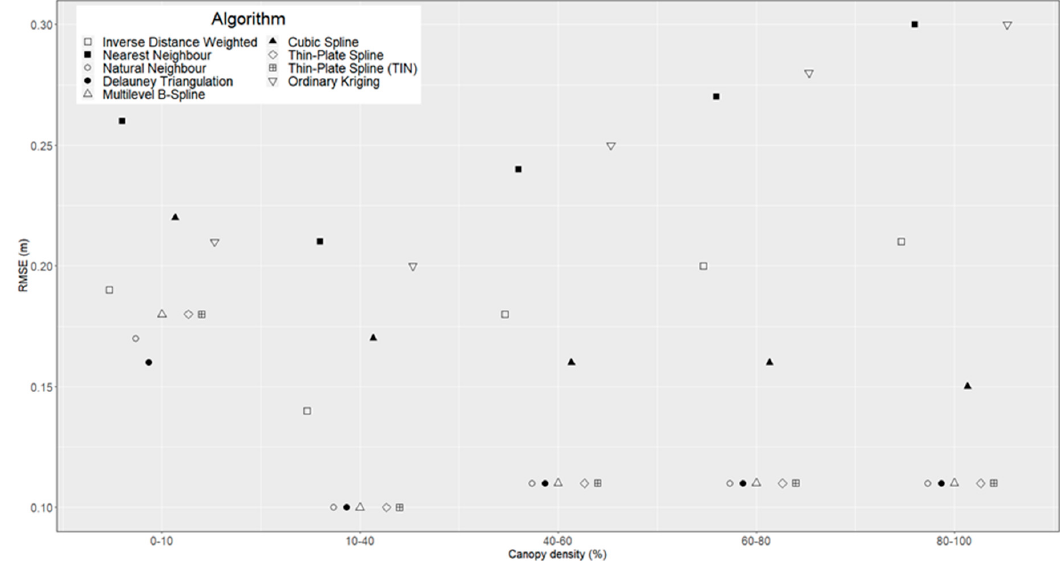
Figure 6. Variation of interpolation accuracy by canopy density class (model resolution: 0.5m). For clarity, points are horizontally offset.